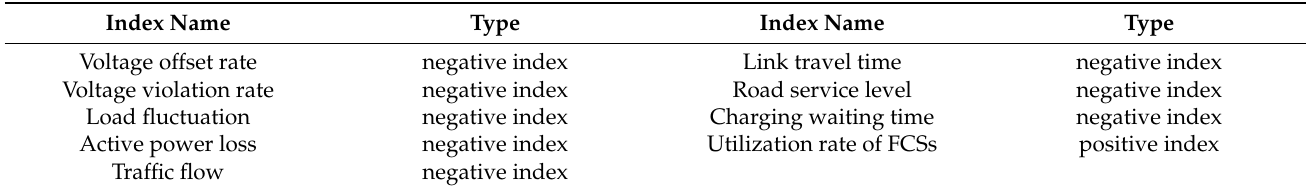
Table 6. Index type.